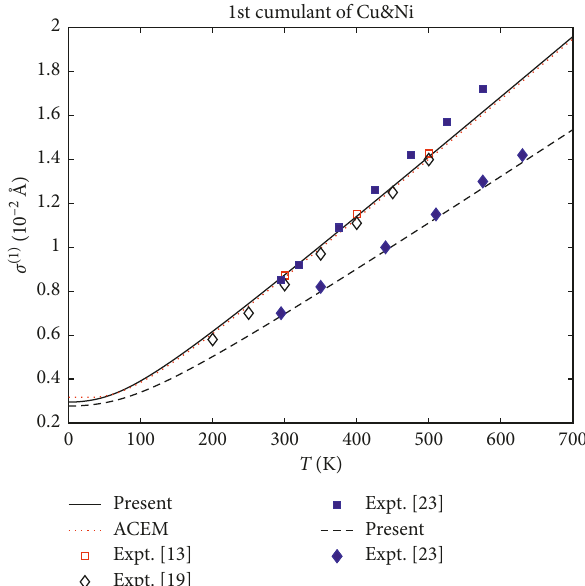
Figure 3: Temperature dependence of first cumulant σ ( 1 ) and Ni calculated using the present theory compared to the ex- perimental values (Expt.) [13, 19, 23] for Cu and [23] for Ni, as well as to those calculated using the ACEM [9] for